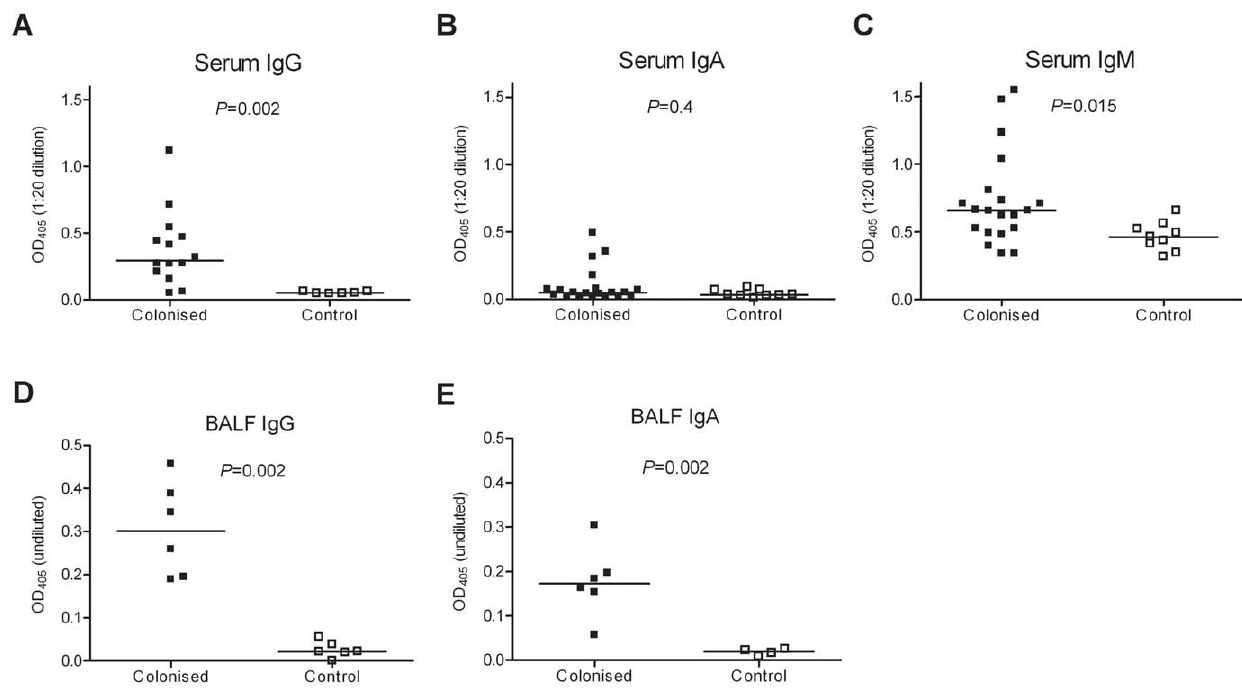
Figure 6. Systemic and mucosal antibody responses to colonisation. IgG (A and D), IgA (B and E) and IgM (C) responses to D39 in serum (A– C) or BALF (D–E) obtained from colonised or control mice measured using whole cell